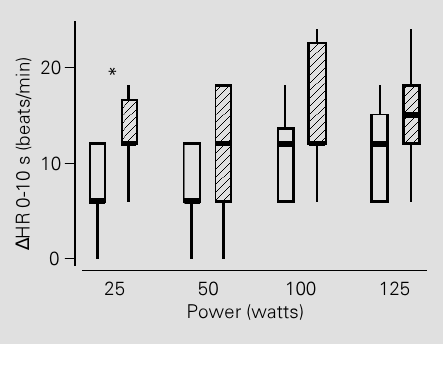
Figure 2 - Increases in HR ( D HR) during dynamic exercise at power values of 25, 50, 100 and 125 watts, in the 1-4-min inter- val ( D 1-4 min) in the sedentary (open boxes, N = 7) and trained (hatched boxes, N = 8) groups. The data are reported as medi- ans, quartiles (1st and 3rd) and minimum and maximum values. *P<0.05.